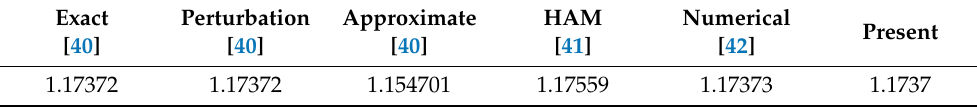
Table 4. Comparison of the values of − f (cid:48)(cid:48) ( 0 ) for a Newtonian